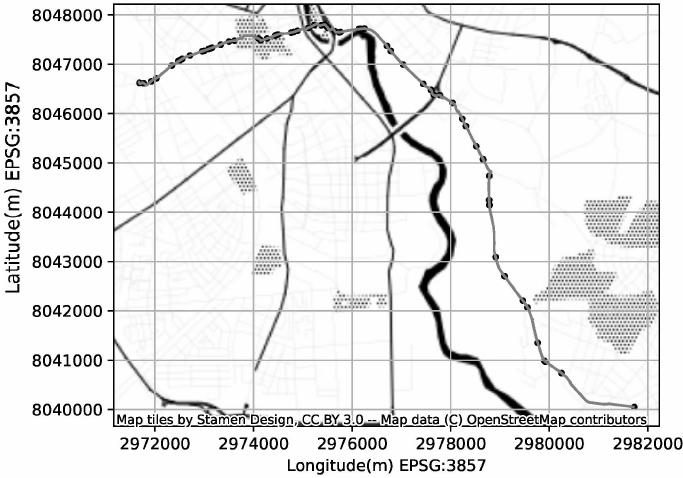
Figure 5. And example of a generated GPS ground truth trajectory (bold gray line) and the corre- sponding CDR events occurrences (black circles).